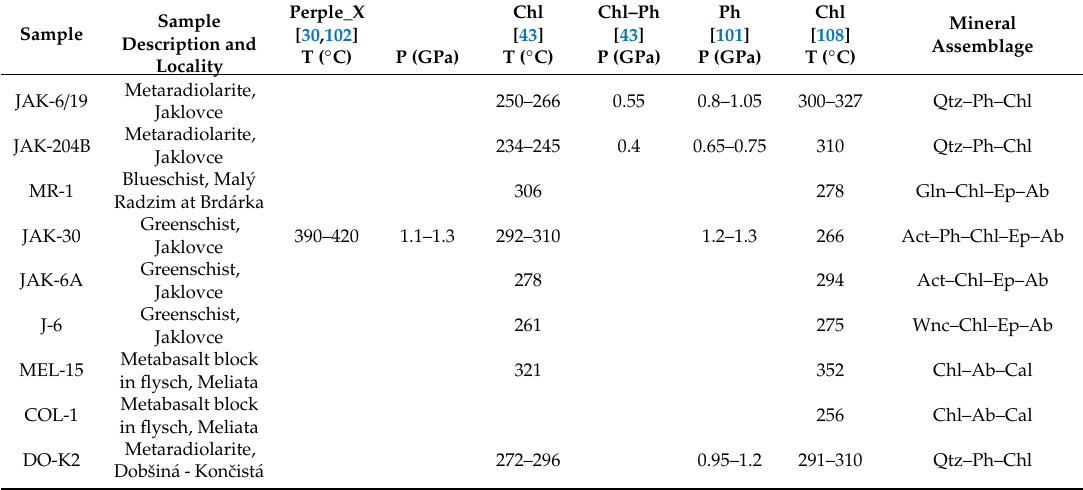
Table 11. Jaklovce Unit rock P–T estimates by combined geothermobarometry.